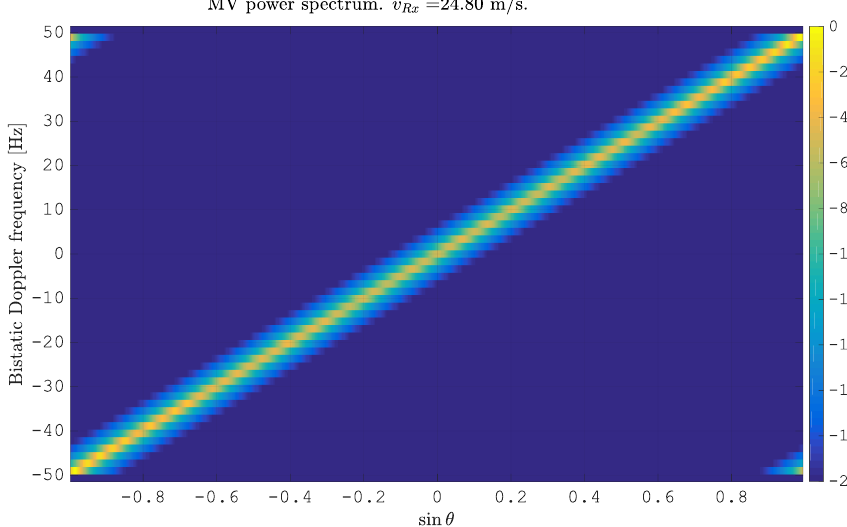
Figure 1. Minimum Variance (VM) power spectrum estimated from simulated clutter for N = 2 spatially displaced antenna elements.